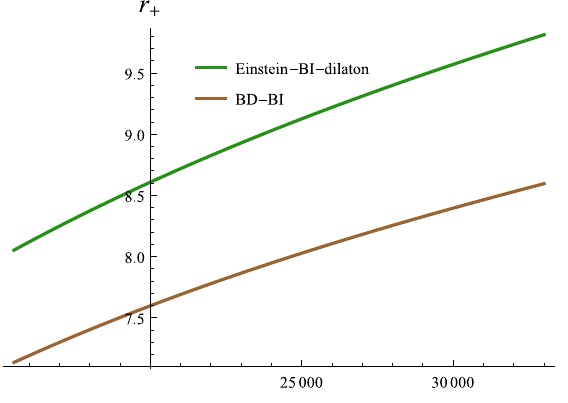
Fig. 13 Horizon radius r + vs. volume V for α = 0 . 25 , n = 4 , b = 1